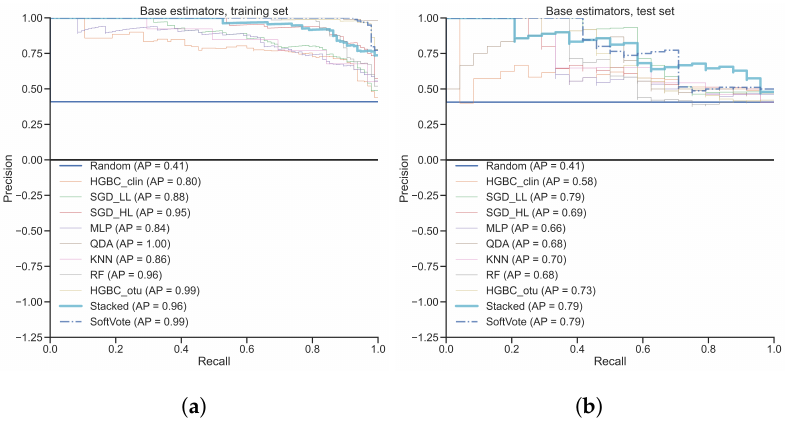
Figure A5. PR curves for stacked model applied on colorectal cancer dataset with strict pre- filtering of microbial features. ( a ) Training set; ( b ) Test set.